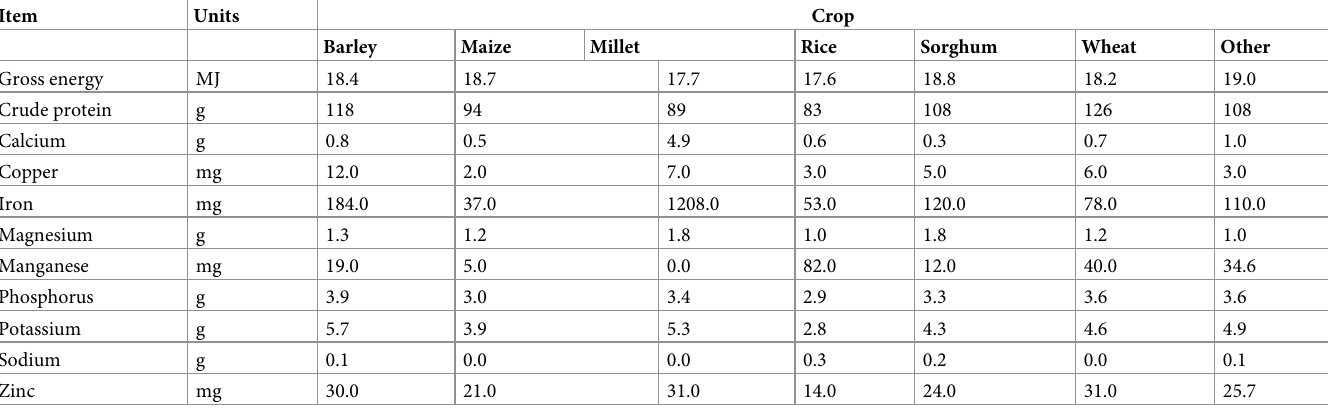
Table 2. Energy and nutritive value of the grains used in the